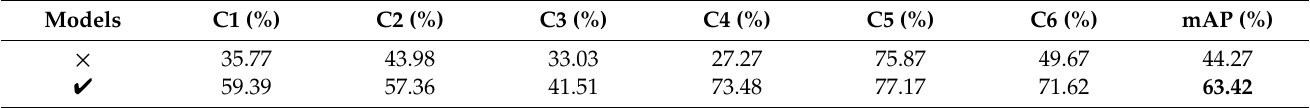
Table 6. Effectiveness of